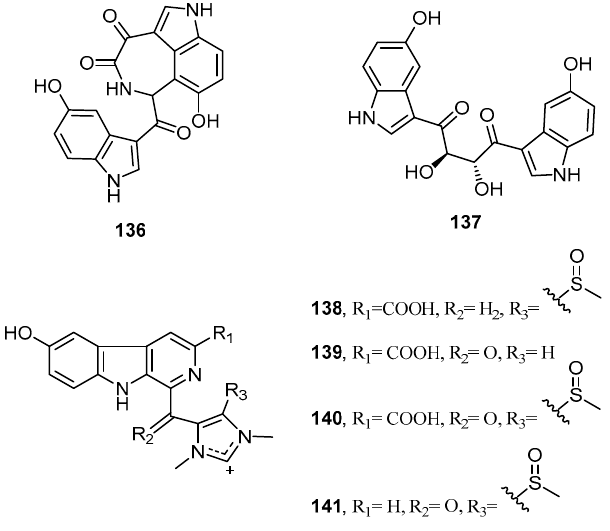
Figure 37. Chemical structures of hyrtimomines F–K ( 136 – 141 ).